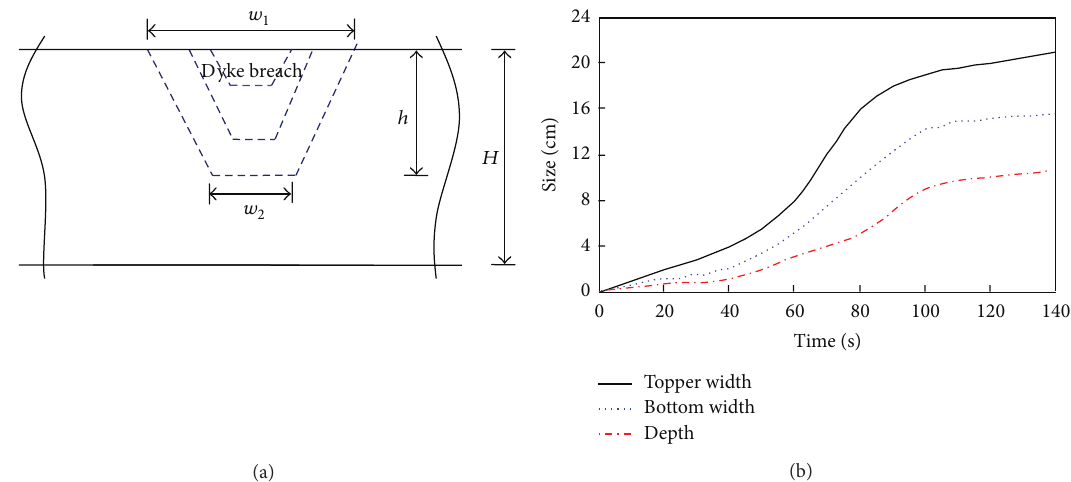
Figure 9: Evolution of the dyke breach when the water flow is 2.0 L/s: (a) schematic diagram and (b) evolution of the size of dyke breach.